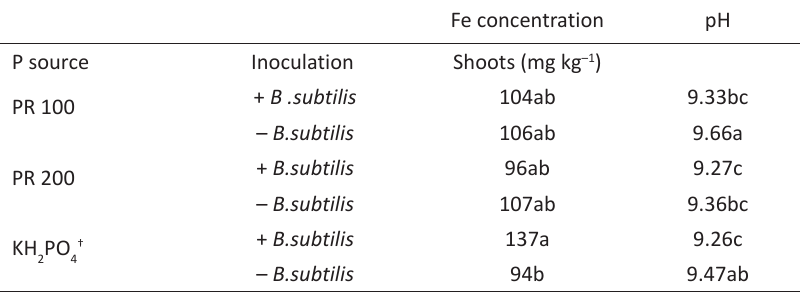
Mean, n = 10; PR = phosphate rock; Means followed by a different lowercase letter in a column were significantly different according to Tukey’s test at p < 0.05 (for combinations of